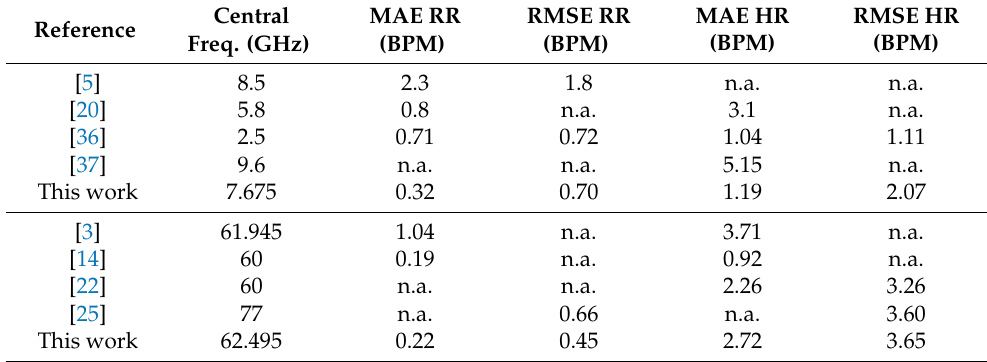
Table 4. Comparison